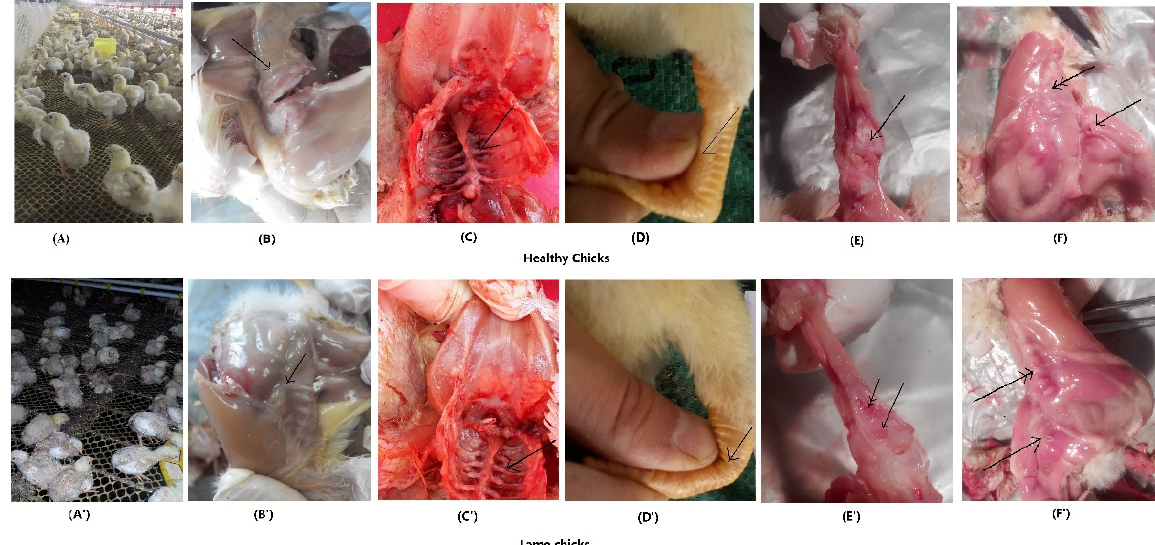
Figure 1. Rickets characteristics apparent in gait features and gross anatomy of 4–11 day-old broiler chicks caused by high- calcium (Ca): phosphorus (P) ratio, P-deficient (HCa:P) crumbled feed. Pictures show changes in walking characteristics ( A / A’ ), ribs ( B / B’ ), costochondral junctions ( C / C’ ), metatarsus ( D / D’ ), tibia proximal tibiotarsus ( E / E’ ), and femur ( F / F’ ).